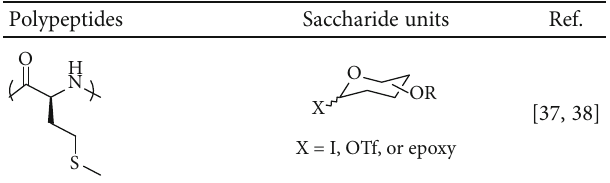
Table 1: Clickable polypeptides and corresponding saccharide units for the synthesis of